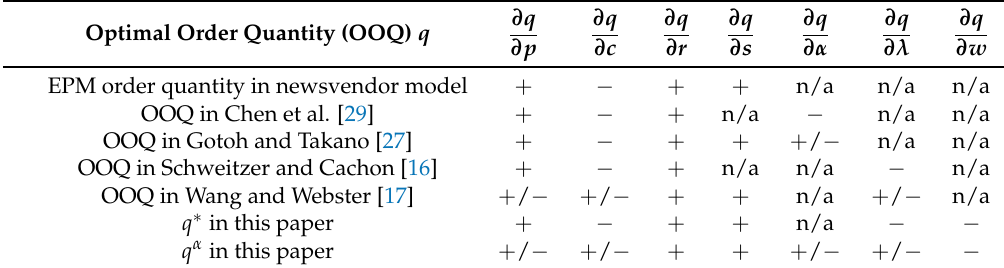
Table 1. Signs of partial derivative of the optimal order